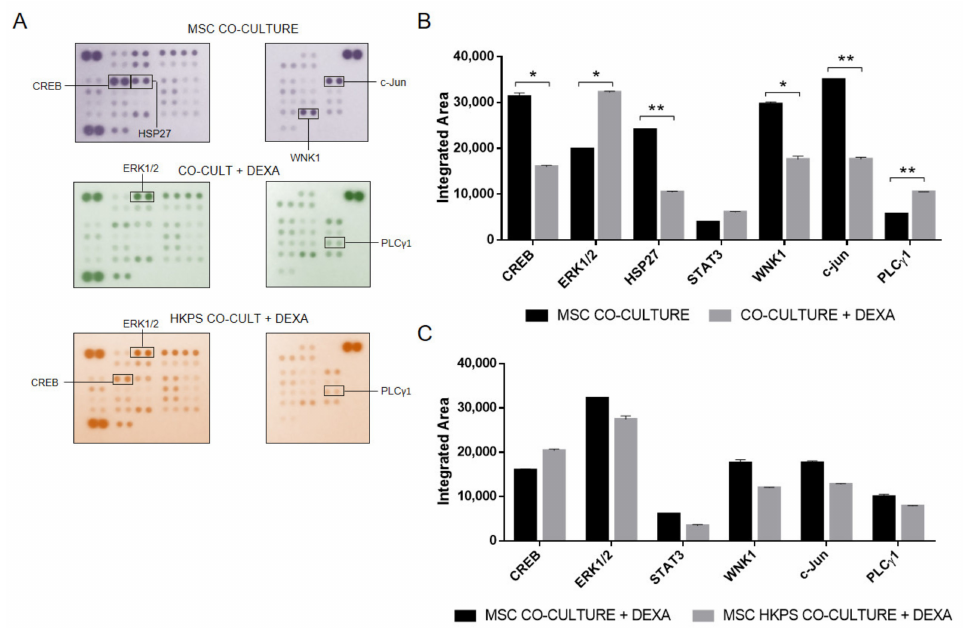
Figure 5. Sensitization to chemotherapy by HKPS could involve other kinases. ( A ) Changes in the phosphorylation profile of MSC after treatment with DEXA. Co-cultures were established with B-ALL cells and treated or not with DEXA (500 nM) for 2 h. In addition, MSC were pre-treated with